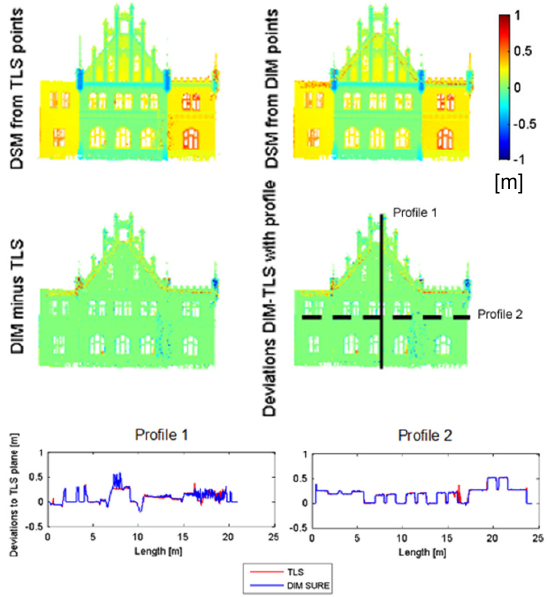
Figure 7. Example evaluation of DIM from the combined UAV/terrestrial image